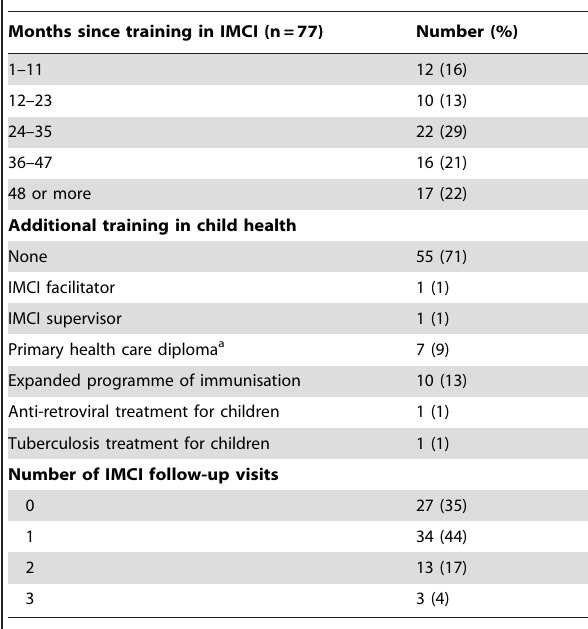
Table 1. Training of observed health workers.